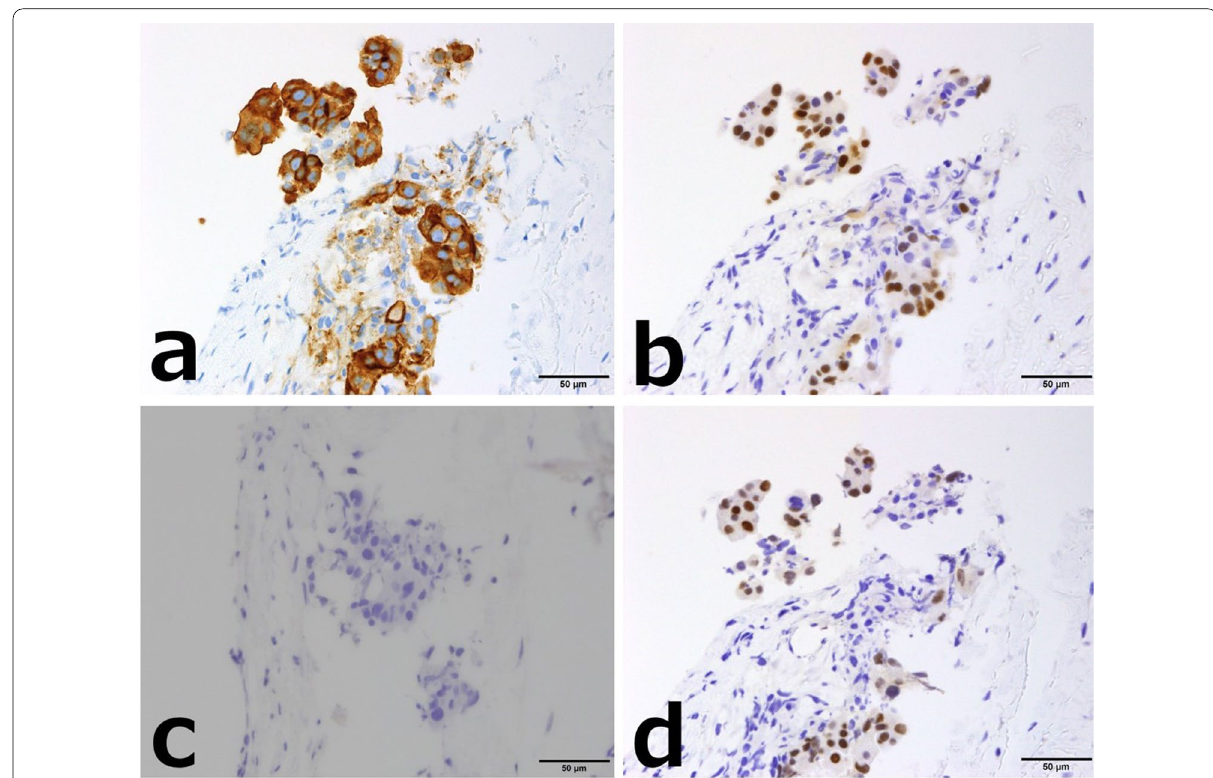
Fig. 7 Case 2: breast tumor histopathology (immunostaining). a CA125. b WT-1. c GCDFP15. d PAX-8. Immunostaining showed positivity for CA125, WT-1, and PAX-8, and negativity for GCDFP15. Notably, PAX-8 is highly specific for Müllerian tube-derived cancer cells and was positive in this case